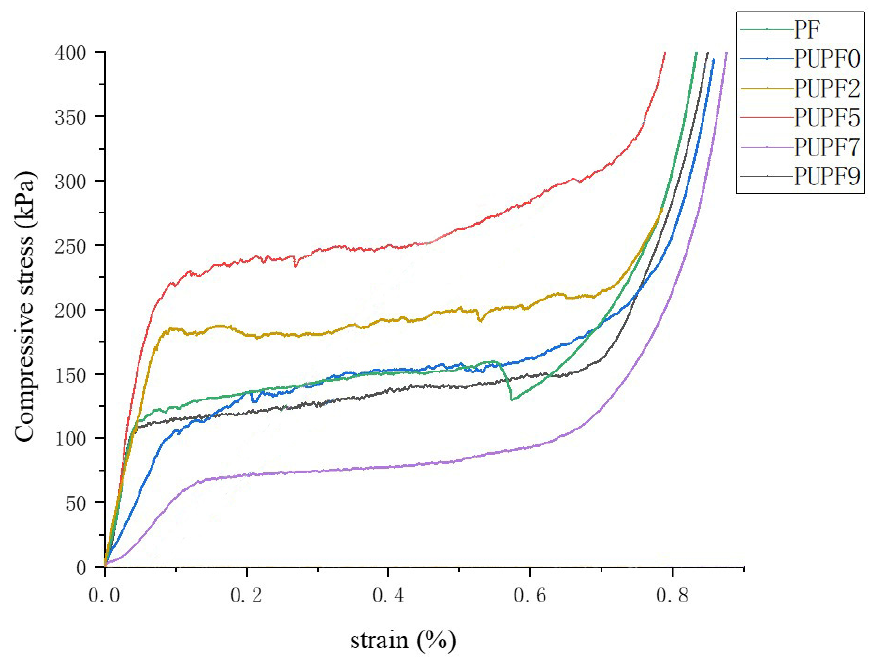
Figure 7. Compressive stress–strain curves.